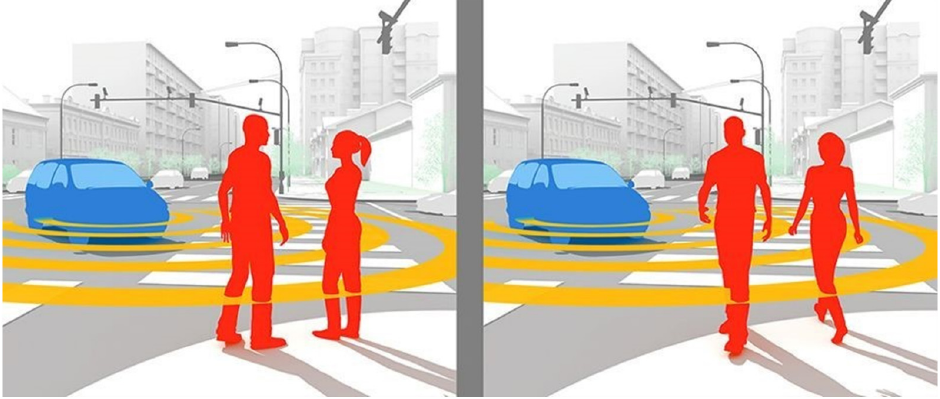
Figure 2. Similar images of pedestrians represent different situations [11].